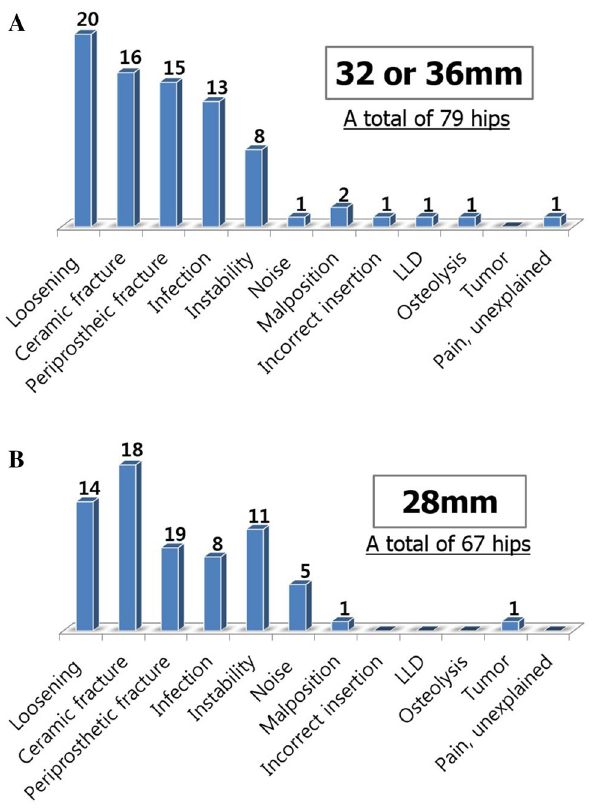
Figure 3. ( A , B ) The reasons for CoC THA revisions according to the femoral head diameter.